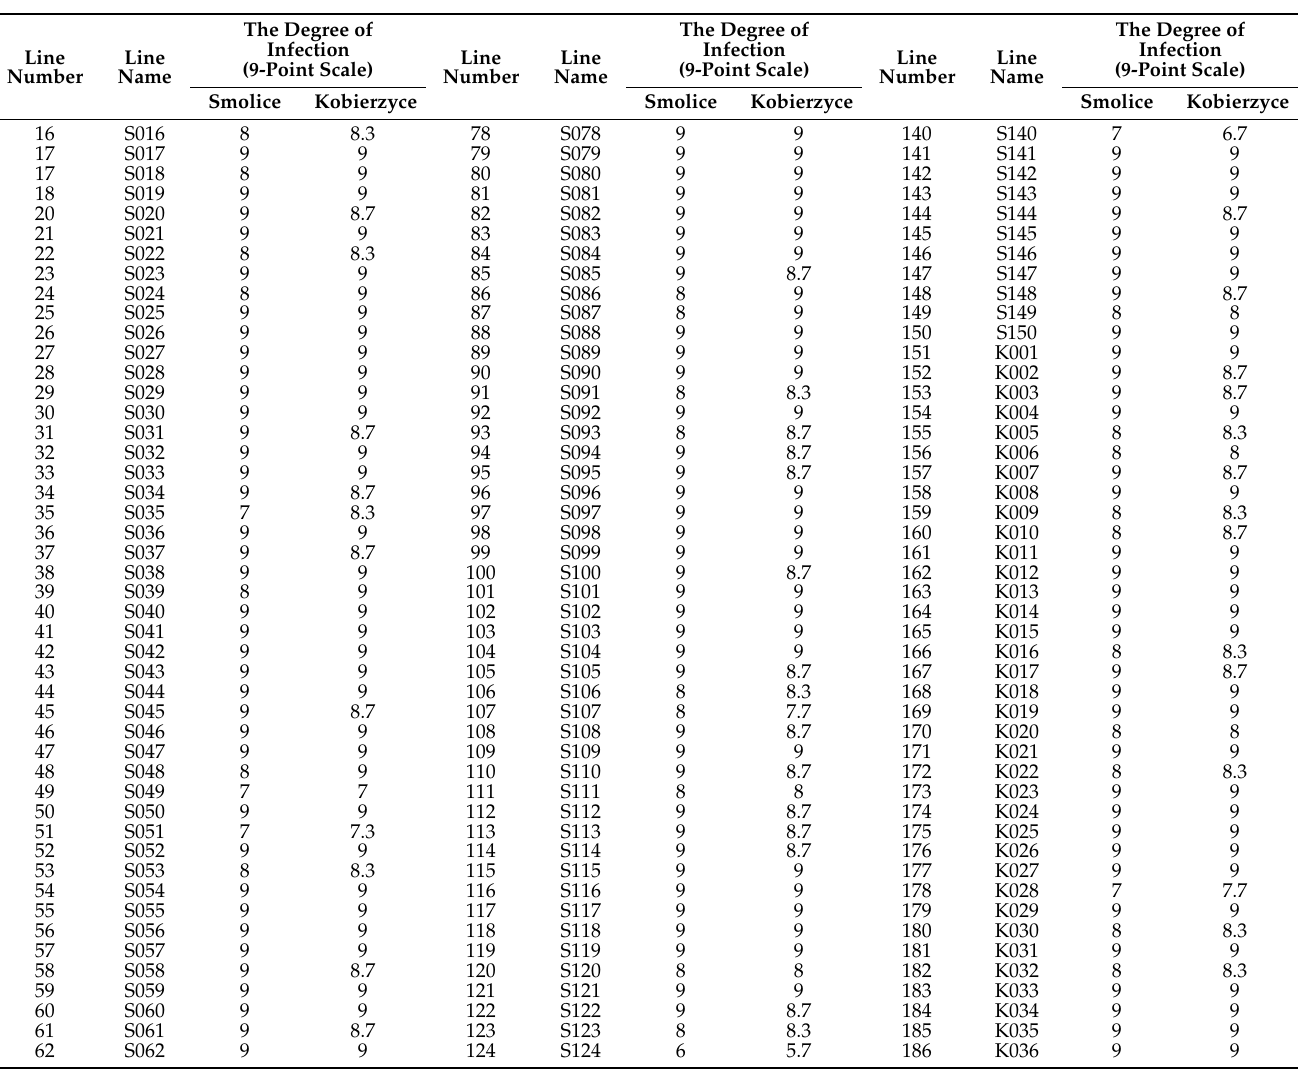
Table 2. Values of F -statistics from two-way analysis of variance for the degree of plant infestation by the fusarium. Source of Variation Location 1 0.18 Lines 251 Location × line